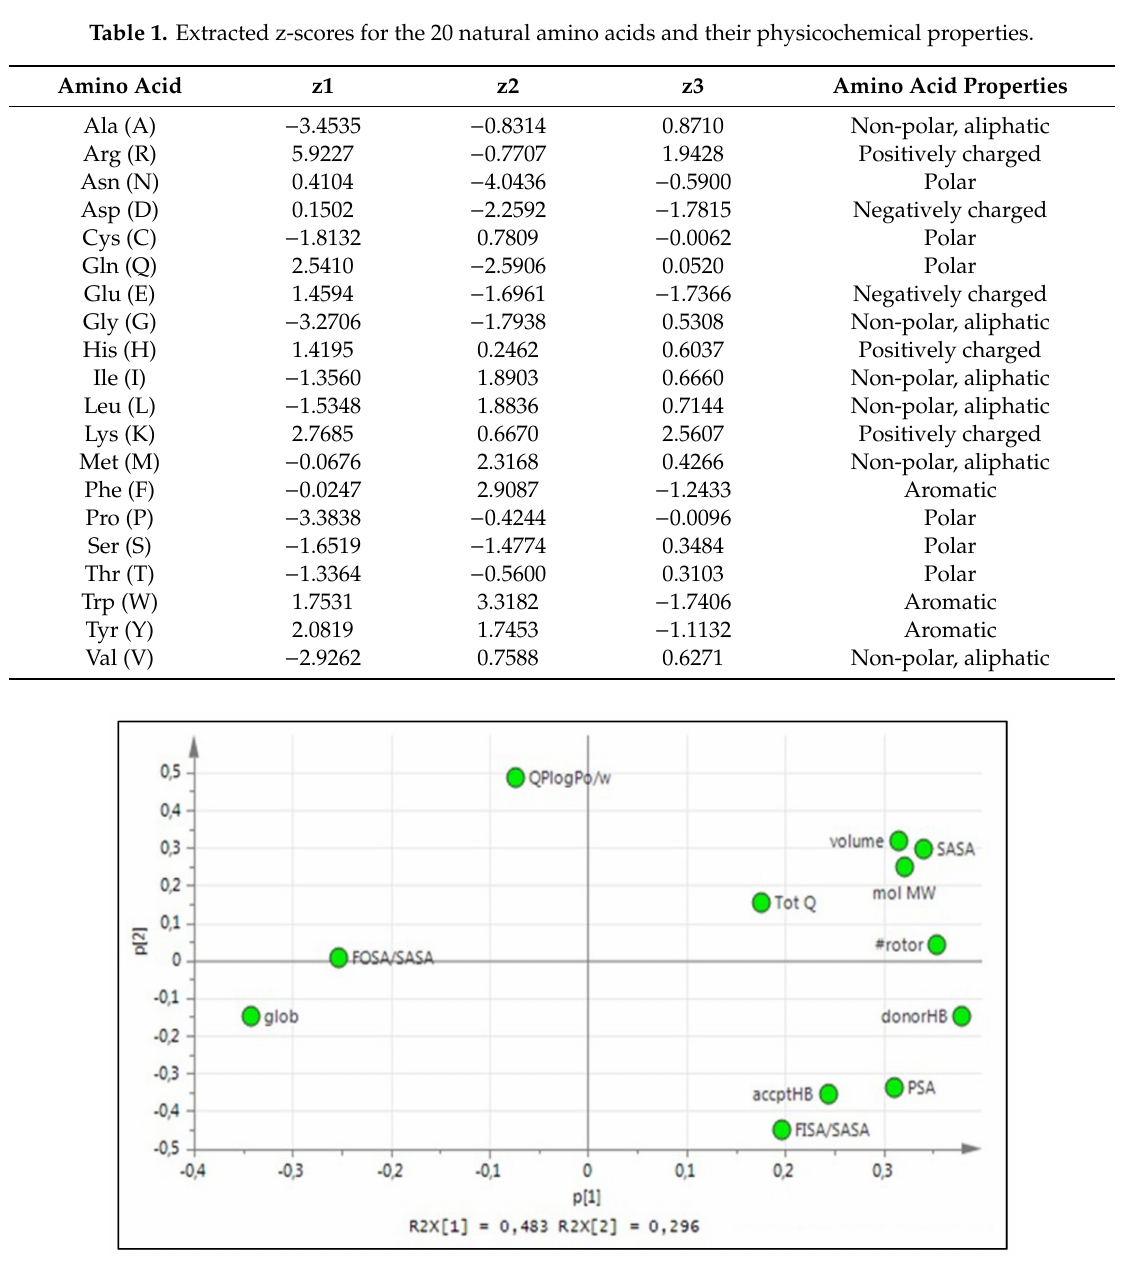
Figure 2. Loading plot explaining PC1 vs. PC2 for the 20 natural amino acids z-scale